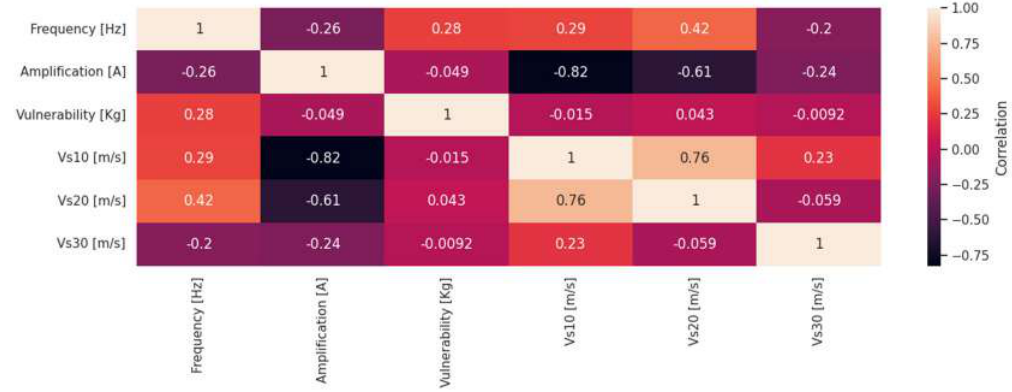
Fig. 8: Correlation index of seismic parameters: frequency, amplification, vulnerability, and shear wave velocities